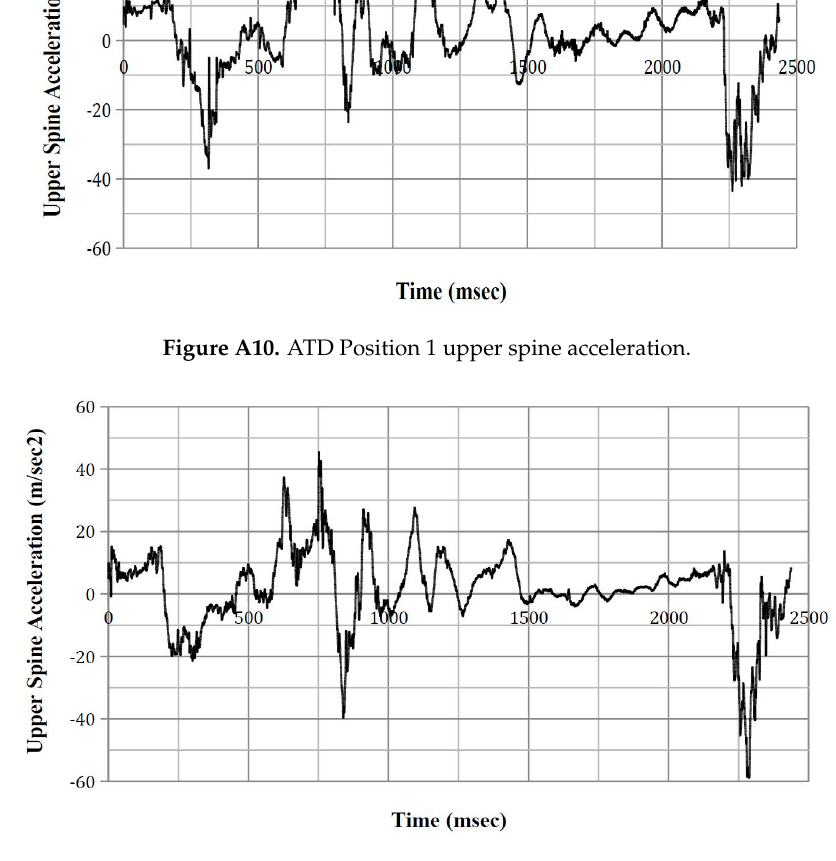
Figure A11. ATD Position 2 upper spine acceleration.